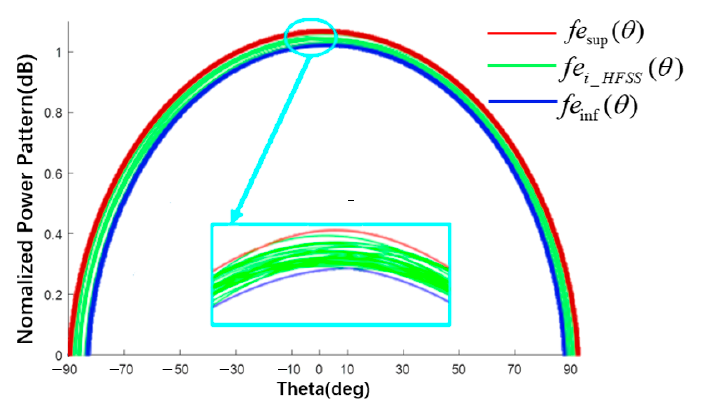
Figure 4. Basic structure of a neuron.